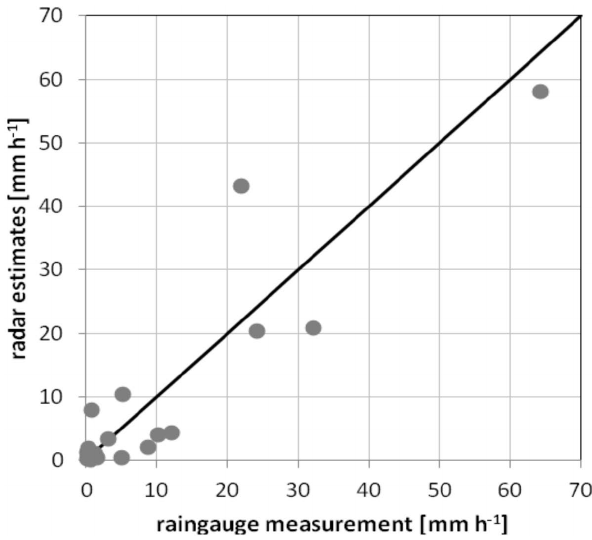
Fig. 4. Scatter plot of adjusted radar rainfall estimates versus raingauge measurements for hourly